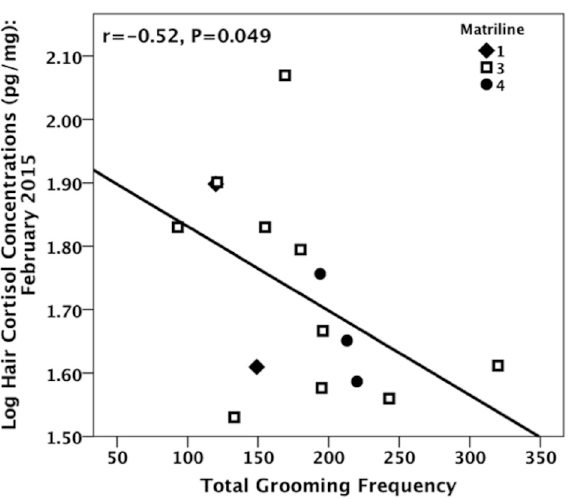
Fig 5. Total grooming frequency and HCC following H1’s removal. Frequency represents total number of intervals grooming occurred from August to February (when the HCC samples were